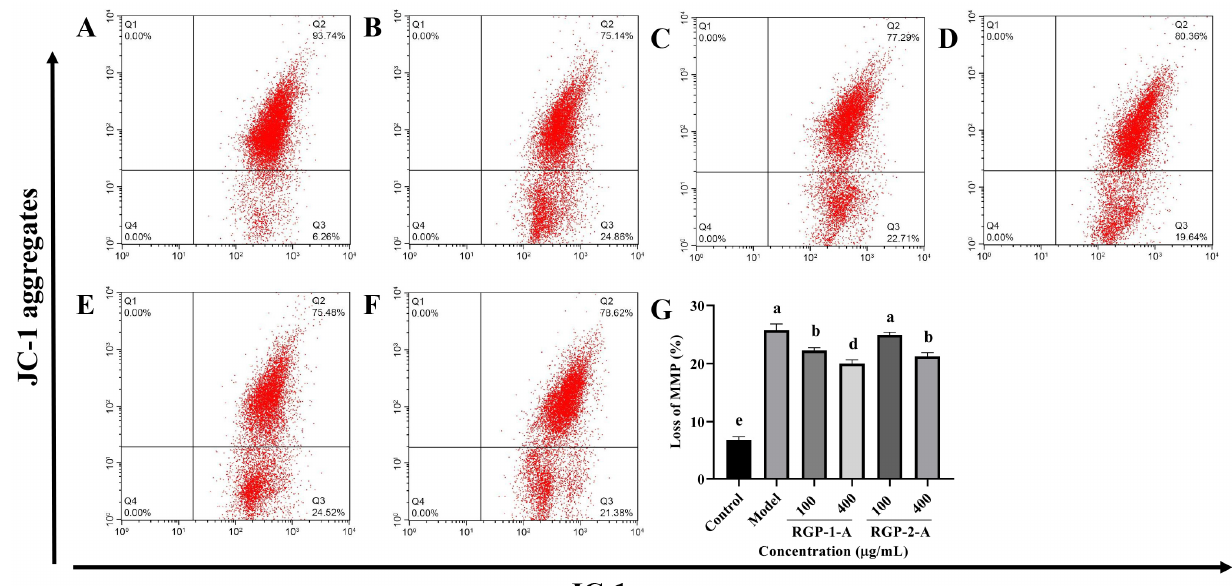
Figure 5. Effect of RGP pretreatment on MMP in LPS-induced IPEC-J2 cells. ( A ): control group; ( B ): model group; ( C ): RGP-1-A low concentration; ( D ): RGP-1-A high concentration; ( E ): RGP-2-A low concentration; ( F ): RGP-2-A high concentration; ( G ):Quantitative analysis of mitochondrial membrane potential changes. Q2 indicates the percentage of IPEC-J2 cells with high MMP, and Q3 indicates the percentage of IPEC-J2 cells with low MMP. RGP-1-A: decolorized pure polysaccharide of RGP obtained using AB-8 macroporous resin; RGP-2-A: decolorized pure polysaccharide of RGP obtained using H 2 O 2 . On the bar graphs, different lowercase letters signify a significant difference ( p <